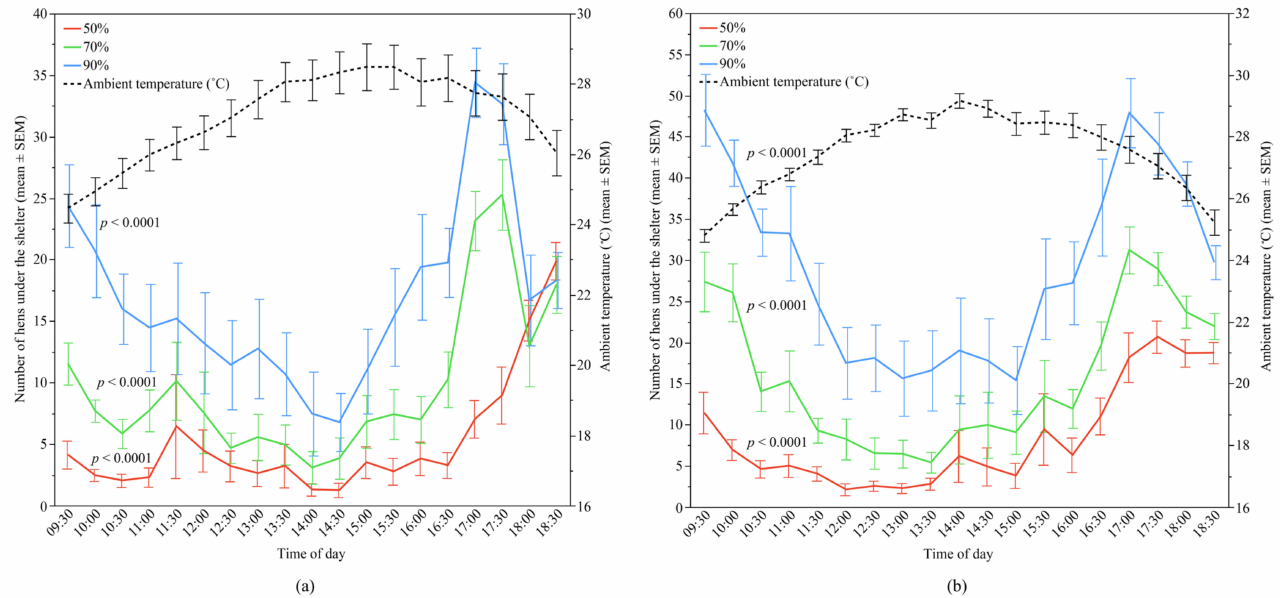
Figure 6. The mean ( ± SEM) number of hens under the different UV-filtering shelters (50%, 70%, and 90%) and the mean ( ± SEM) ambient temperature throughout the day: ( a ) Flock-A; ( b ) Flock-B ( p > 0.10 indicates the variable had no significant effect and was removed from final model). Note the different Y-axis scales between Flock-A and Flock-B. Raw values are presented with analyses conducted on transformed